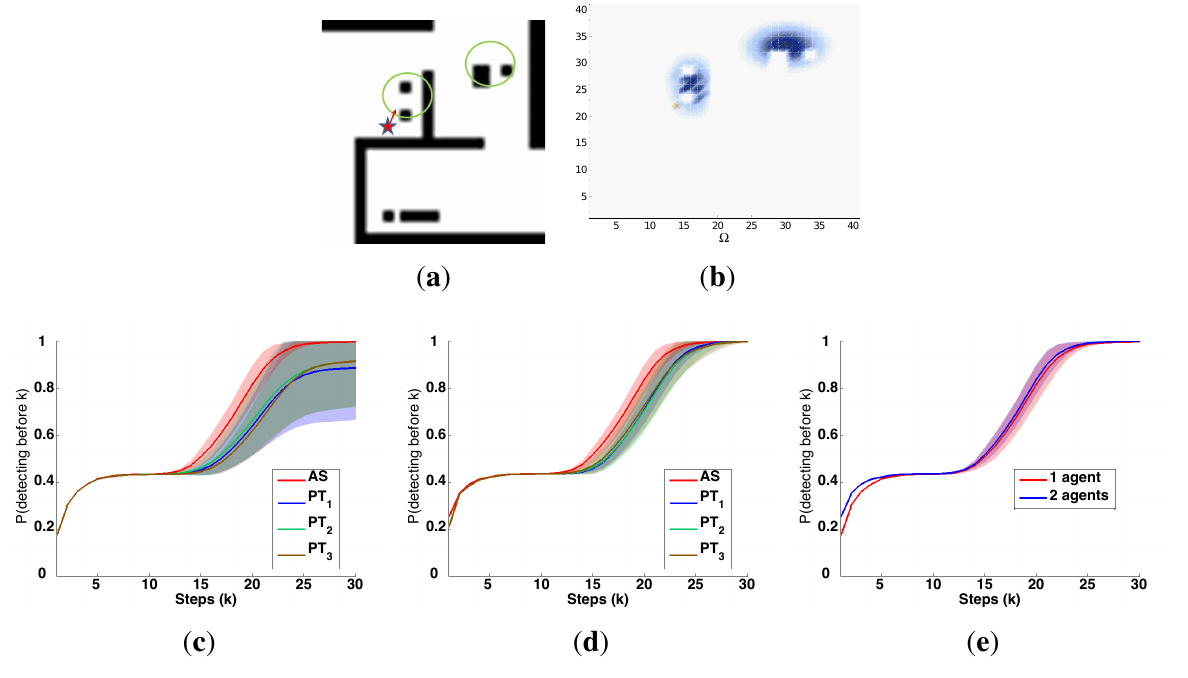
Figure 10. Properties and IG curves of the static ultrasonic scanner experimental